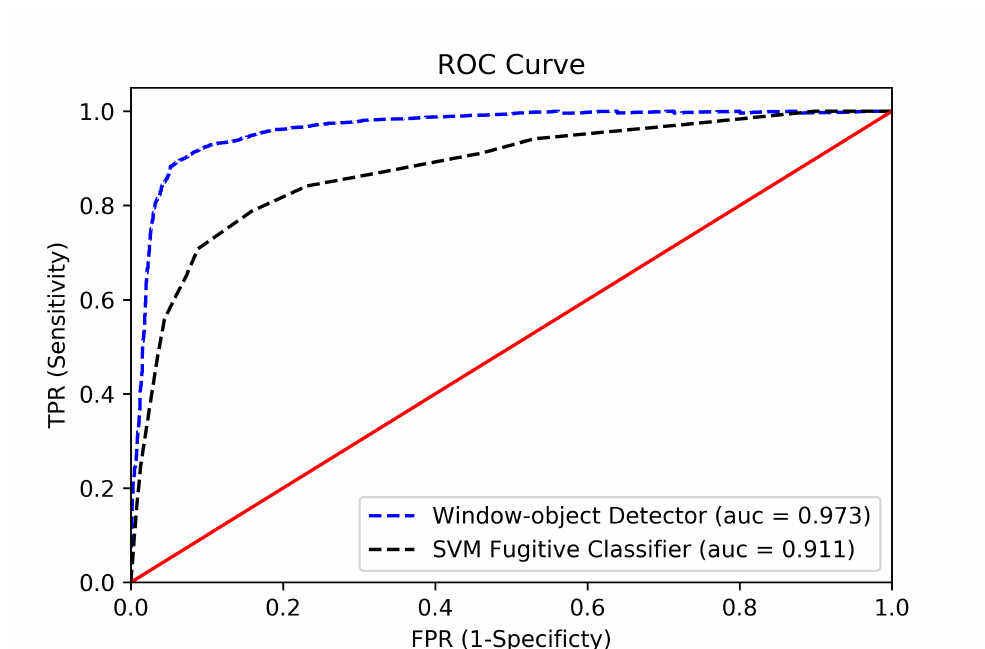
Figure 16. ROC curves for the window-object detector fugitive